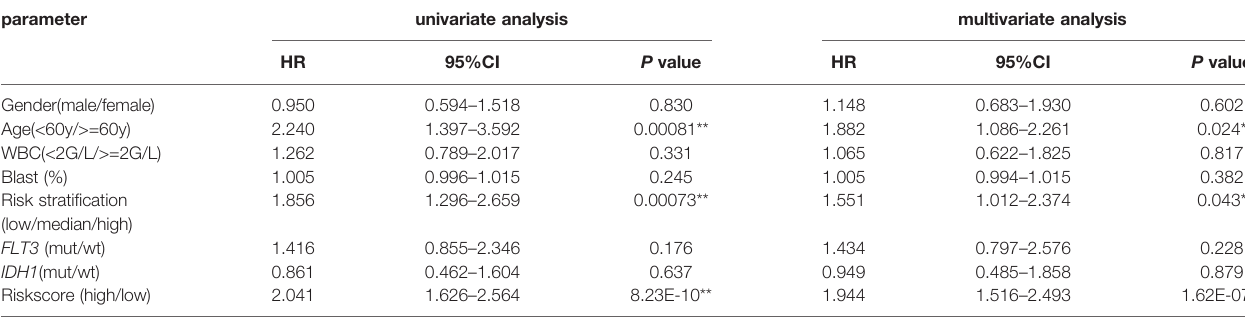
TABLE 3 | Univariate and multivariate overall survival (OS) analysis of CXCR signature in AML patients. parameter univariate analysis multivariate analysis